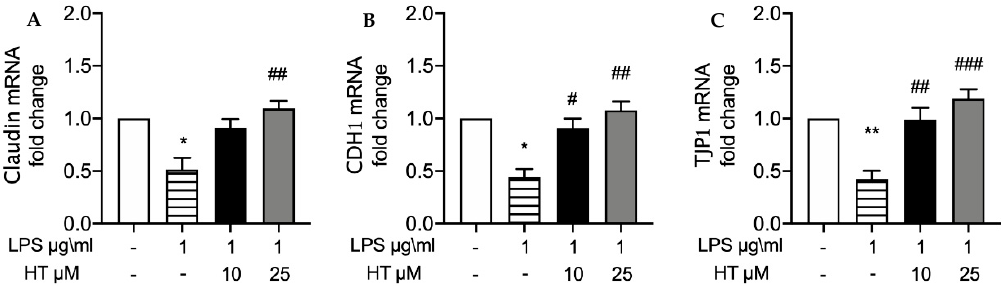
Figure 2. HT pre-treatment on LPS-induced changes in tight junction expressions Nrf2 in BEND cell: mRNA levels of Claudin ( A ), CDH1 ( B ) and TJP1 ( C ). * p < 0.05 vs control; # p < 0.05 vs. LPS; ## p < 0.01 vs. LPS; ** p < 0.01 vs. control; ### p < 0.001 vs. LPS.